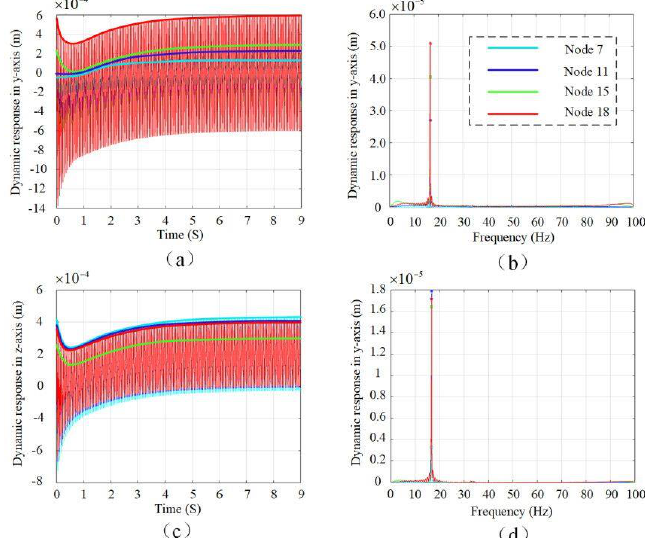
Figure 12. The dynamic response of GCRS with the bearing stiffness of 2 nm. ( a ) The time domain dynamic response in the y -axis. ( b ) The frequency domain dynamic response in the y -axis. ( c ) The time domain dynamic response in the z -axis. ( d ) The time domain dynamic response in the z -axis.